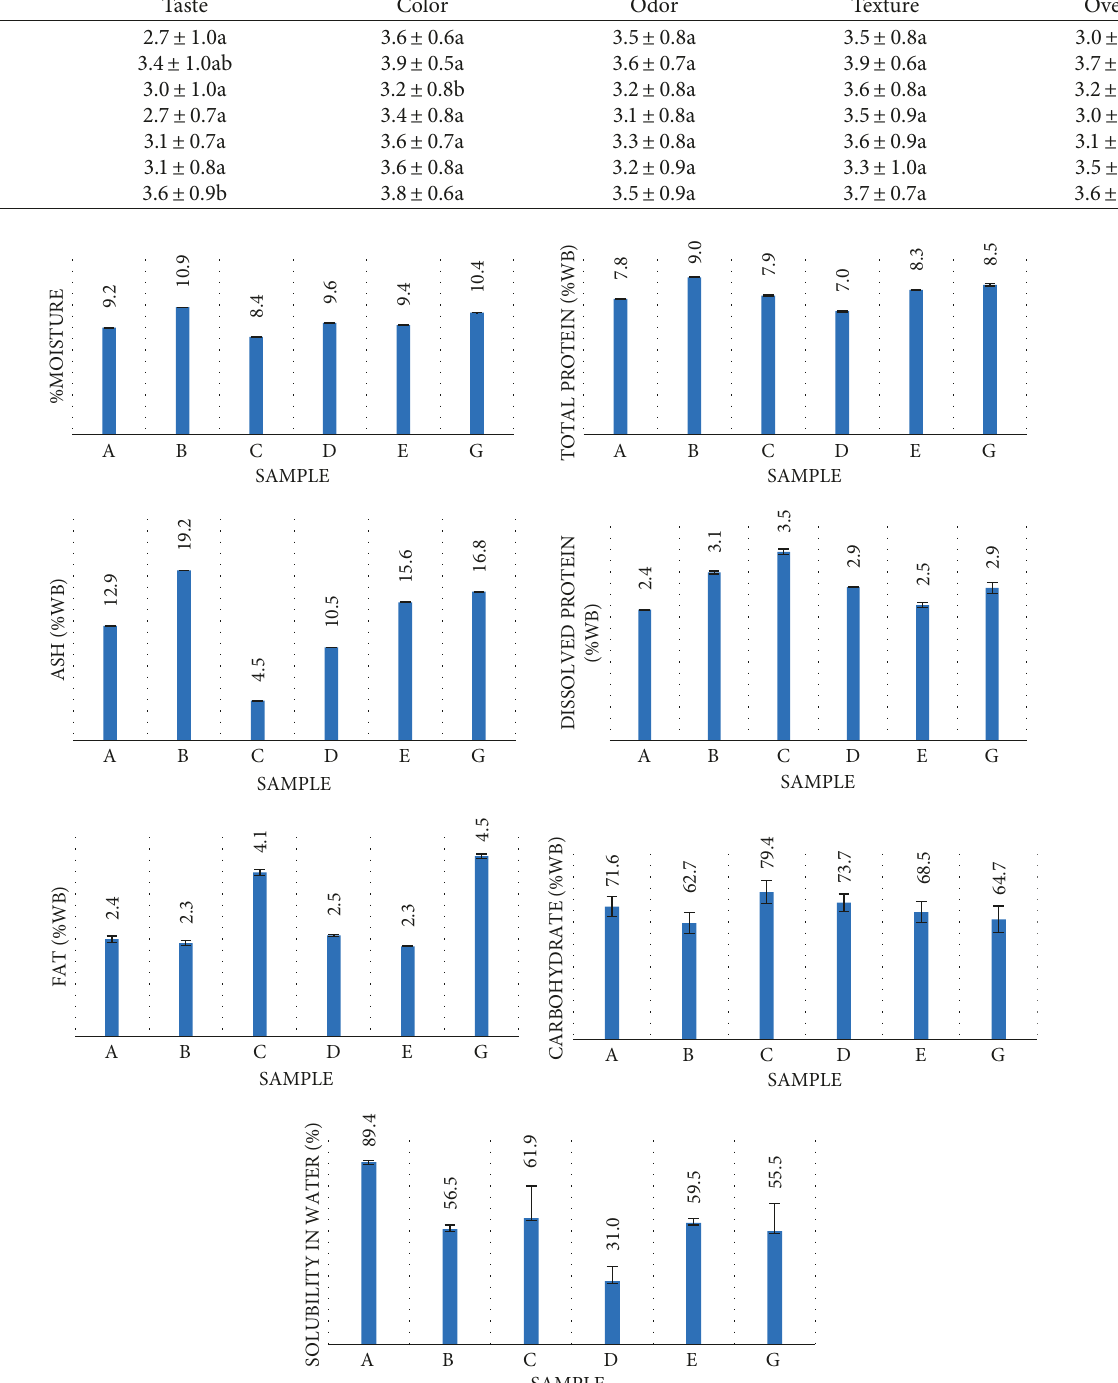
Figure 1: Results of the proximate analysis, soluble protein, and water solubility.